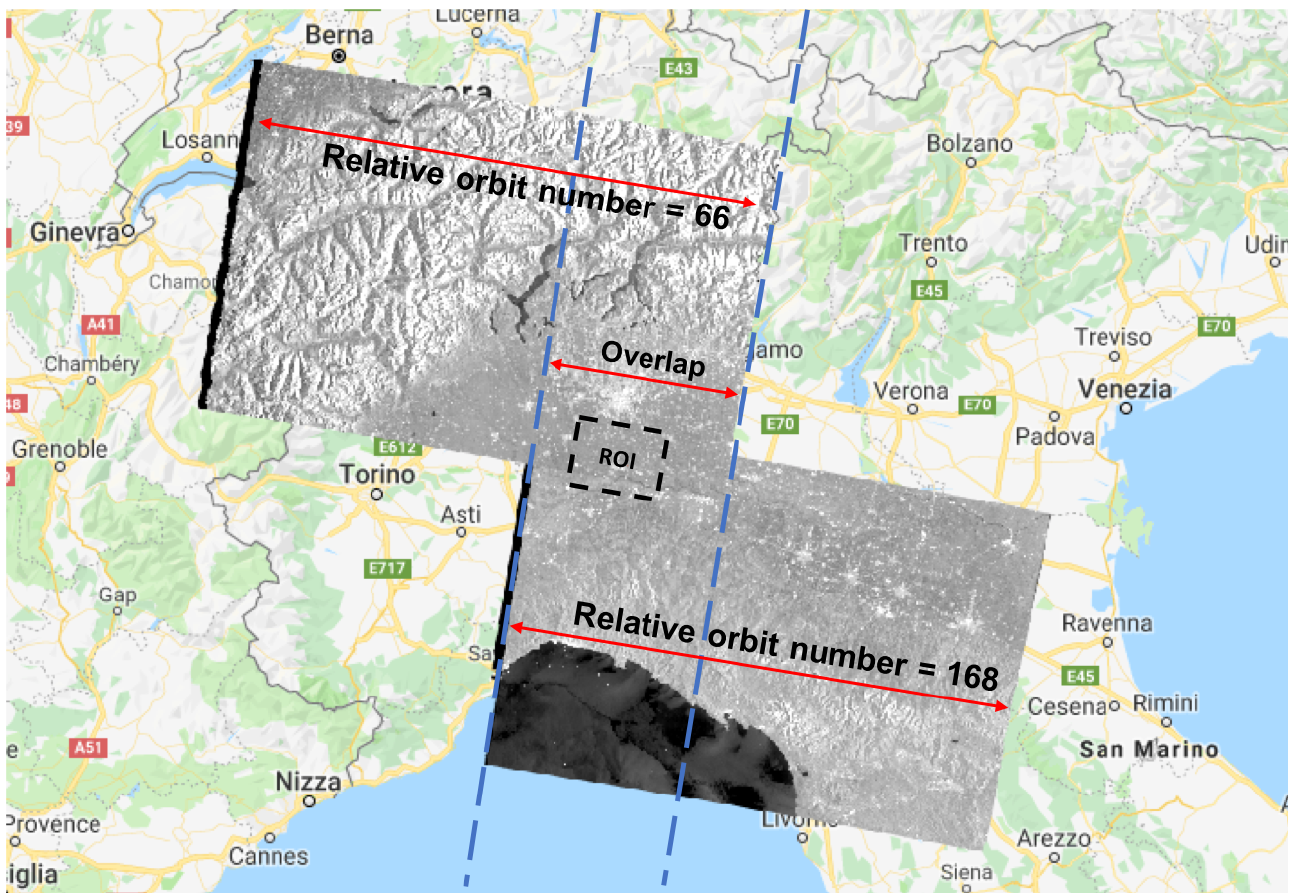
Figure 2. Overlapping of two descending Sentinel-1 orbits over the region of interest (ROI). Orbit number 66 (top left) and orbit number 168 (bottom right) overlap around our ROI. Background map from Google Maps ©.